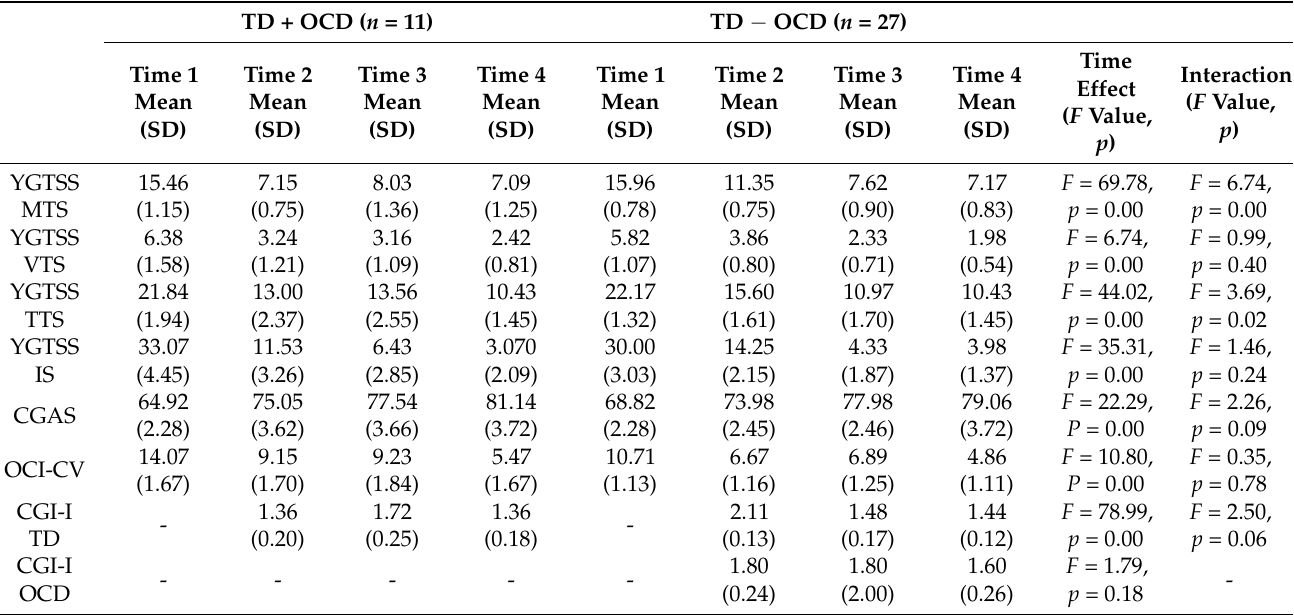
Table 3. Baseline (time 1), post-intervention (time 2) and 3-month (time 3) and 6-month (time 4) scores on measures of TD and